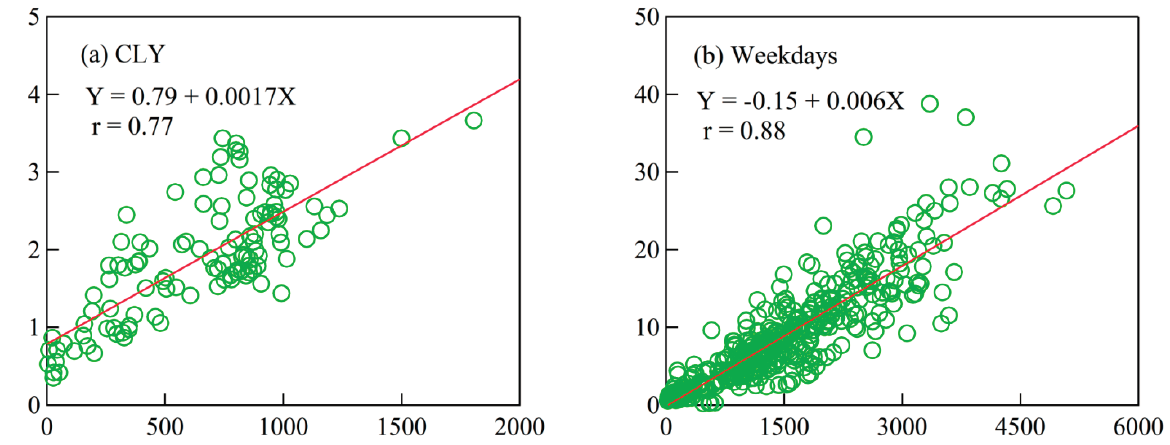
Figure 6. Scatter plots of hourly rBC concentrations versus Δ CO mixing ratios during the ( a ) Chinese Lunar Year (CLY) and ( b ) weekdays. The solid lines show linear fits to the